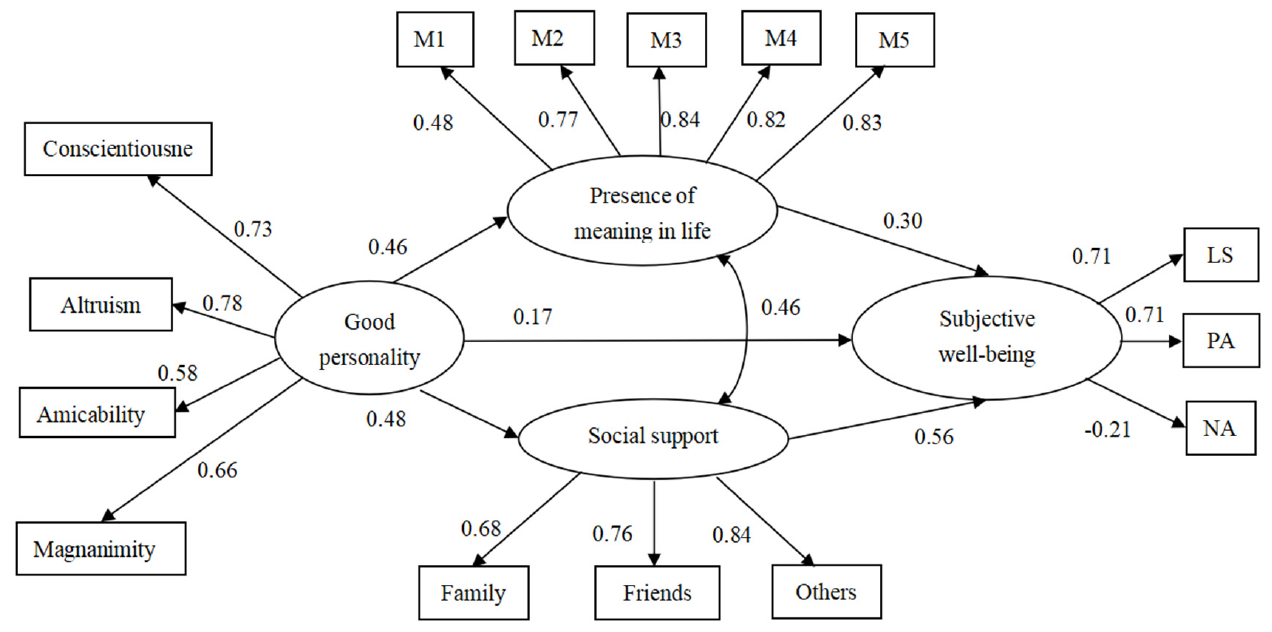
Figure 1. Finalized structural model (N = 665). Factor loading is standard. M1–M5 = five items of presence of meaning in life; PA = positive affect; NA = negative affect; LS = life satisfaction.